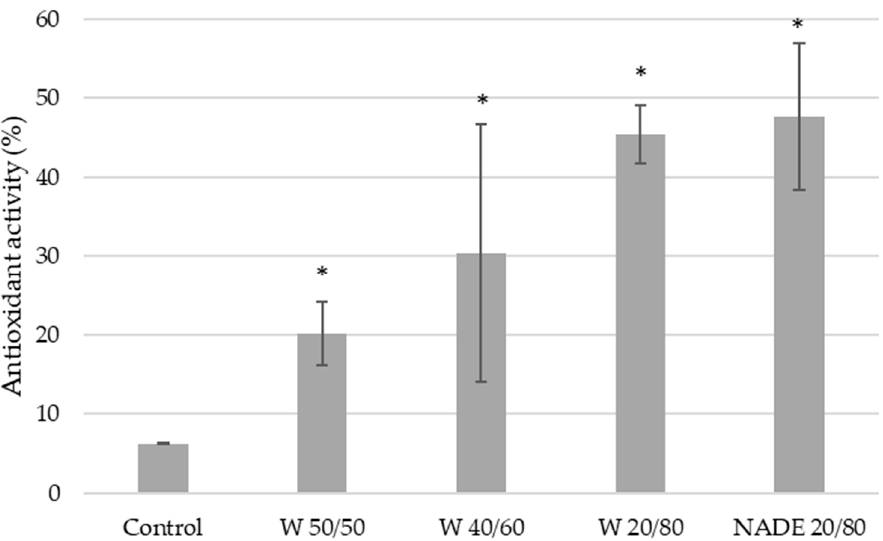
Figure 8. Antioxidant activity (%) of the electrospun nanofibers. *—statistical differences for p <